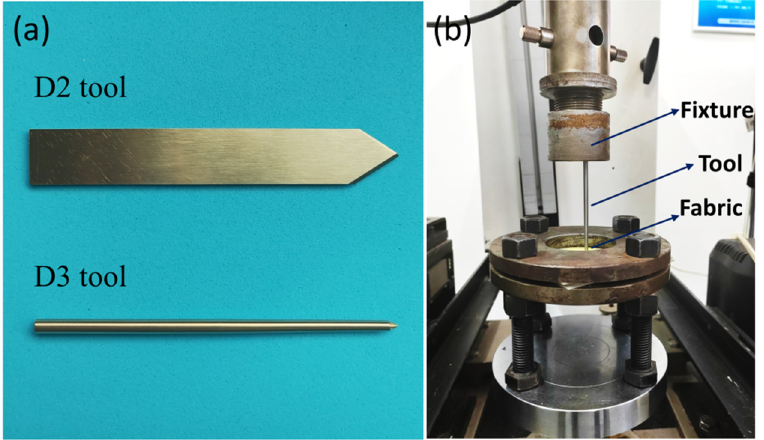
Figure 8. Test tools and equipment used in the quasi-static impact experiments.( a ) Test tools ; ( b ) Test